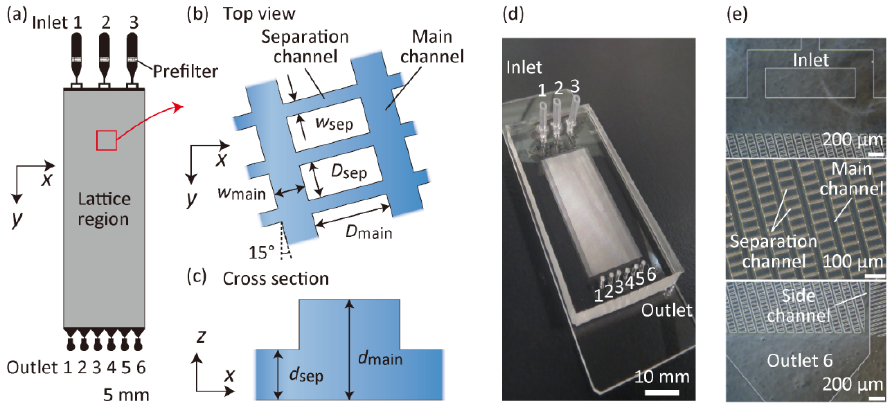
Figure 2. Microchannel design and photographs of the microfluidic devices. ( a ) Top view of Microdevices A–C, ( b ) enlarged image of the lattice region, and (c ) cross-sectional view of the lattice region. w main : width of the main channel; w sep : width of the separation channel; d main : depth of the main channel; d sep : depth of the separation channel; D main : interchannel distance of the neighboring main channels; D sep : interchannel distance of the neighboring separation channels. ( d ) Photograph of the prepared Microdevice A and ( e ) microscopic images showing the inlet, lattice, and outlet regions of Microdevice A. Table 1. Parameters of six types of fabricated microfluidic devices. The parameters correspond to those shown in Figure 2. The size ratio indicates the relative size ratios for Microdevices A, D, E, and F.